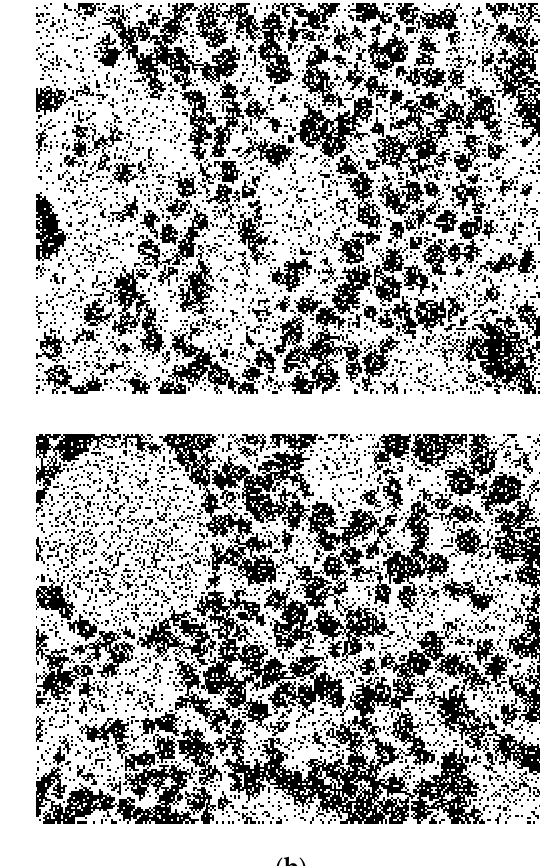
Figure 3. Particle of copper powder in a material sintered at 700 °C ( a ) and distribution of elements in the cross section of the particle ( b ).